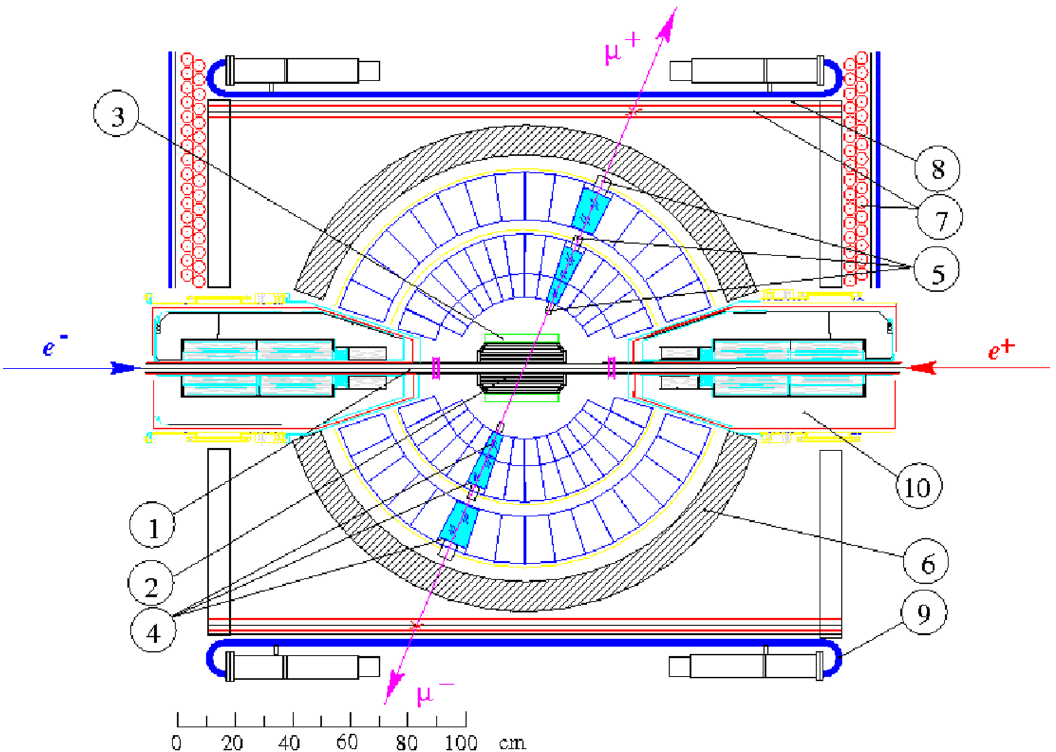
Figure 1 . SND detector, section along the beams: (1) beam pipe, (2) tracking system, (3) aero- gel Cherenkov counters, (4) NaI (Tl) crystals, (5) vacuum phototriodes, (6) iron absorber, (7) proportional tubes, (8) iron absorber, (9) scintillation counters, (10) solenoids of